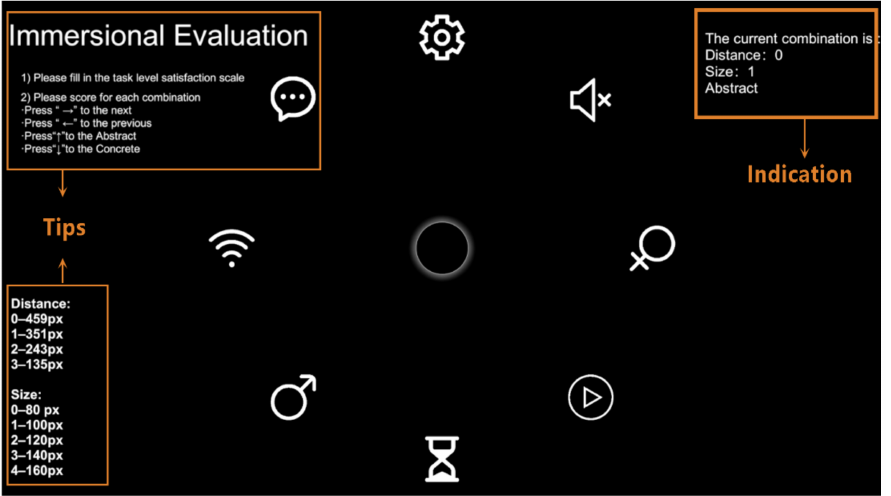
Figure 9. Immersive evaluation: The upper left is the operation method. The upper right is the current variable combination. The lower left is the number of distance and area variables. The current combination presented in the figure means the distance is 459 px (Marked as 0), the size is 100 px (Marked as 1), and abstract